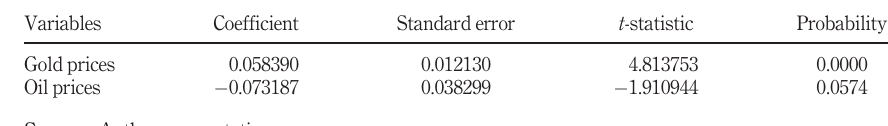
Table 5. Long-run coef fi cient of